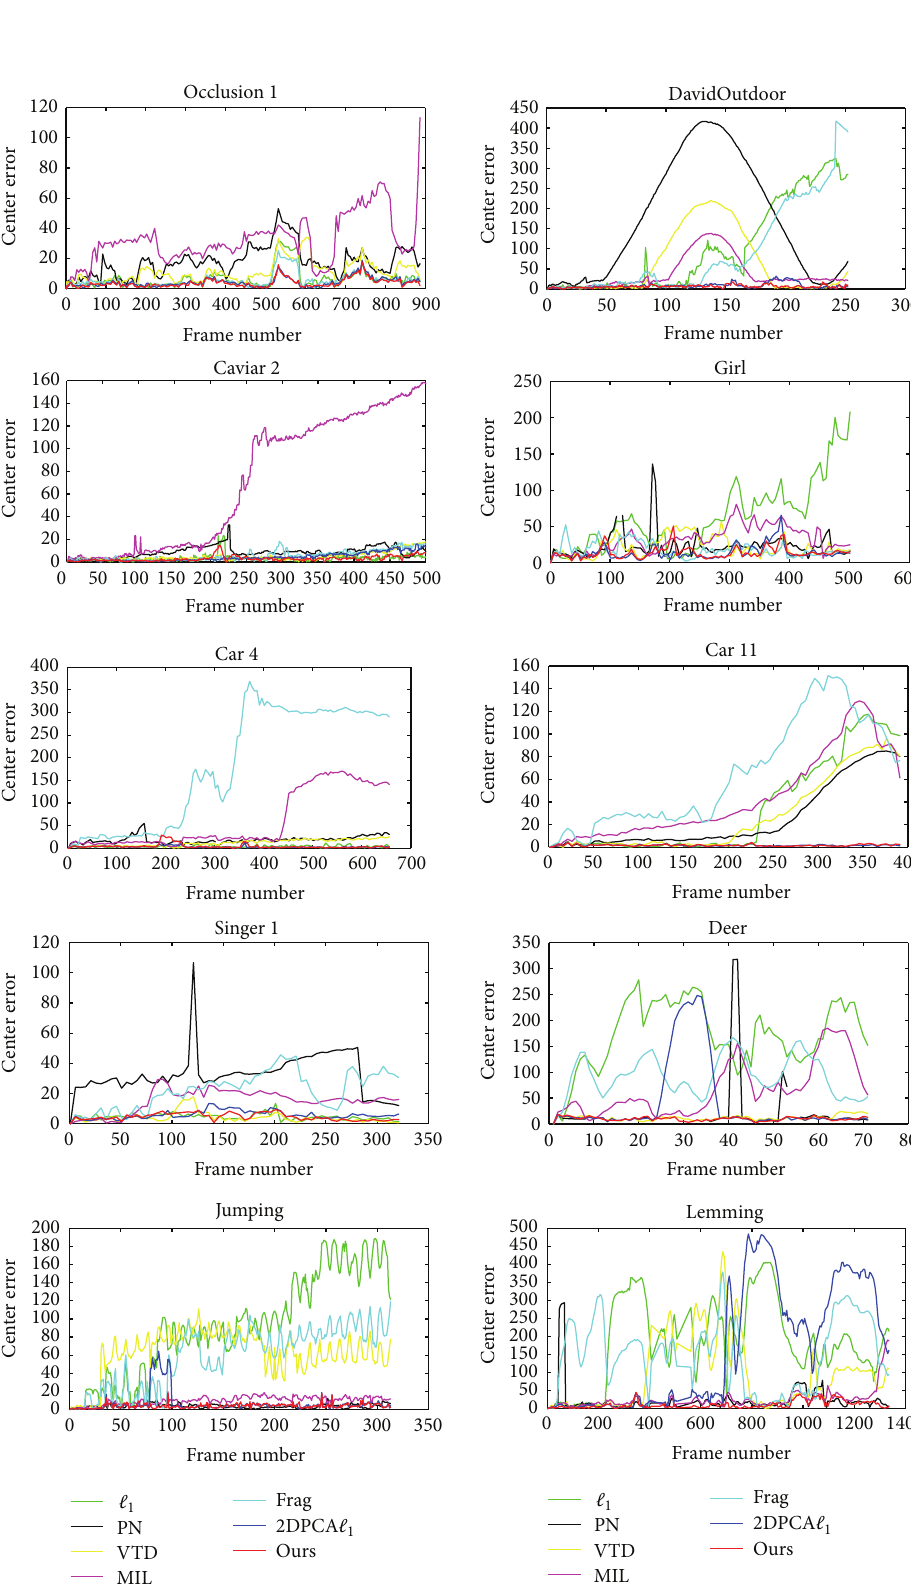
Figure 2: Center location error (in pixels)